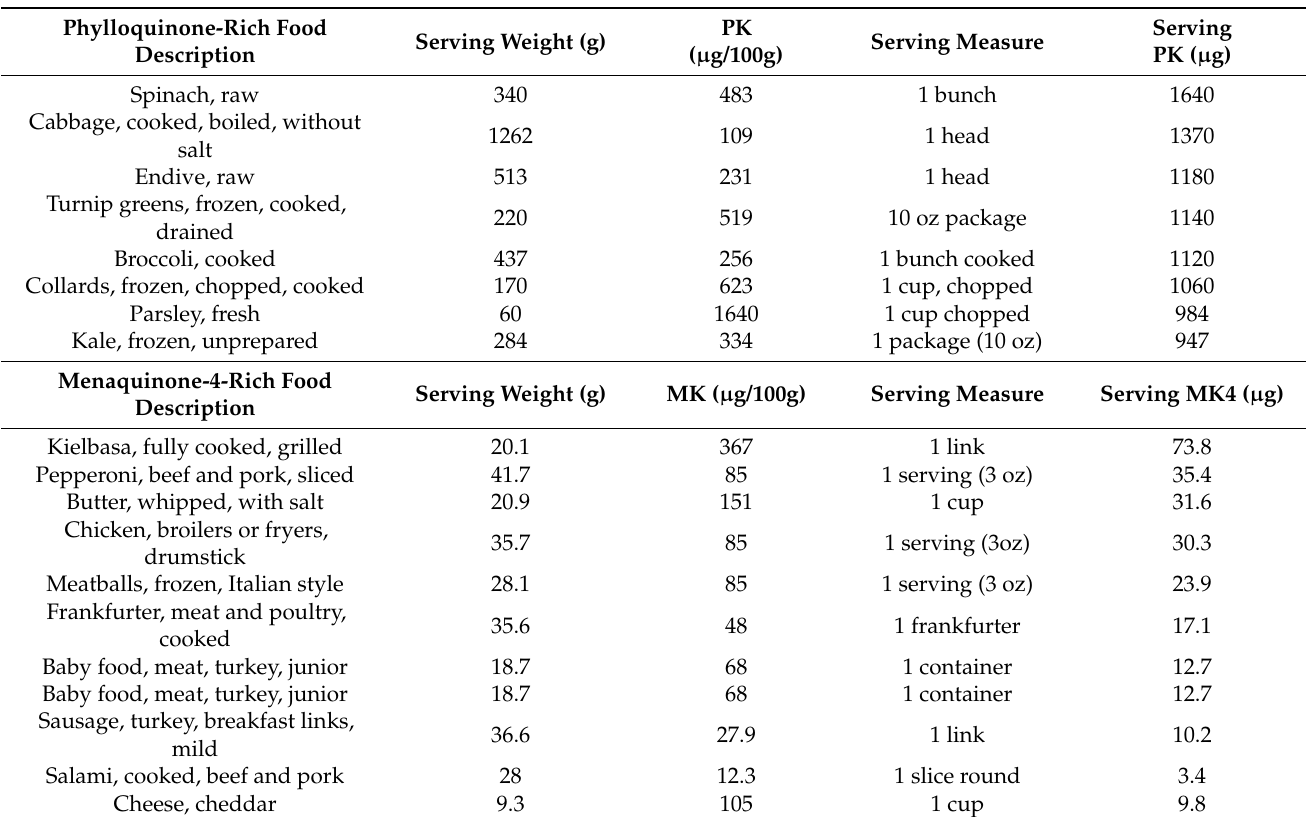
Table 1. Common foods ranked by relative VK ( µ g) amount per typical serving for PK and MK4 from the USDA FoodData Central